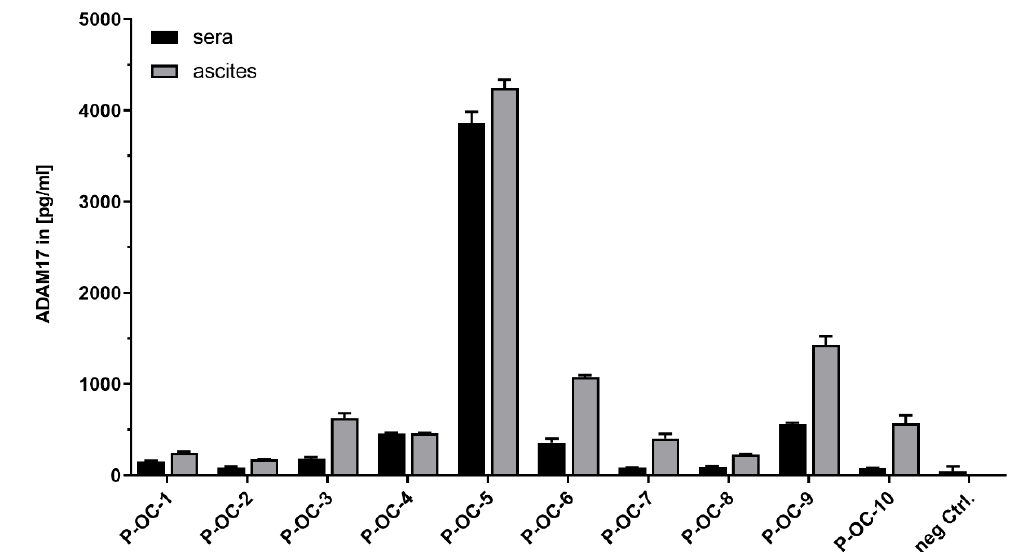
Figure 2. Detection of ADAM17 in ascites and in the serum of patients. Measured ADAM17 concentrations in ascites and serum were matched for each patient for better comparability. ADAM17 levels in ascites samples were on average 2.5 times higher than ADAM17 amounts in serum ( p = 0.0049, Wilcoxon rank test). As a negative control, we used serum from a non-age-matched female donor (neg. Ctrl.).